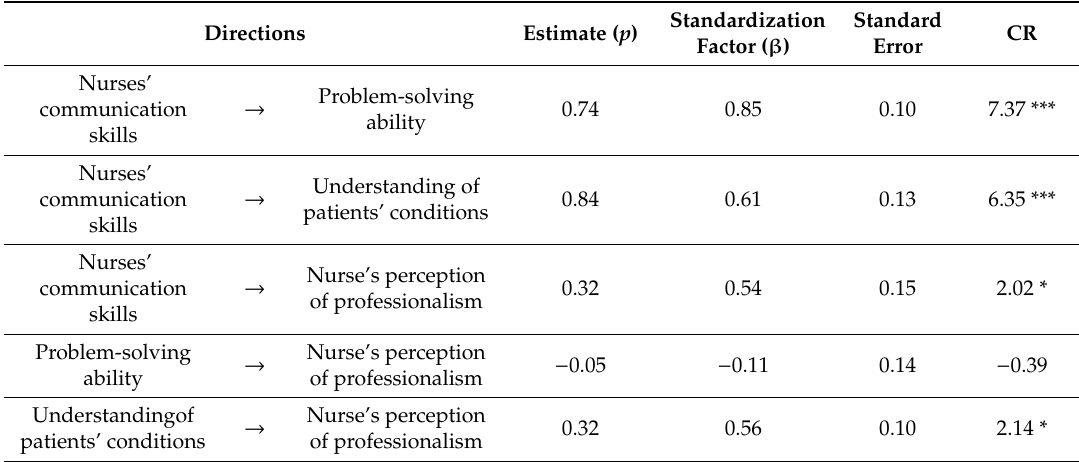
Table 5. The relationships between the human e ff ects of the measurement model.